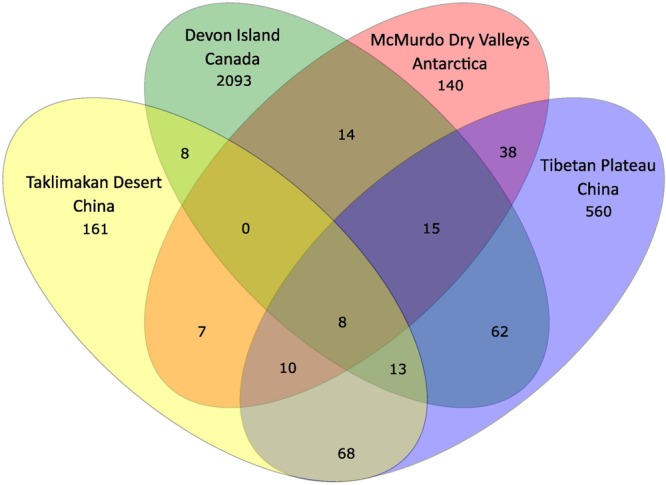
Venn diagram illustrating distribution of OTUs among the four locations. Taxonomic classification of 16S rRNA gene sequences was made using the Ribosomal Database Project Classifier (Wang et al., 2007). A full list of all OTUs is given in Supplementary Table S2.